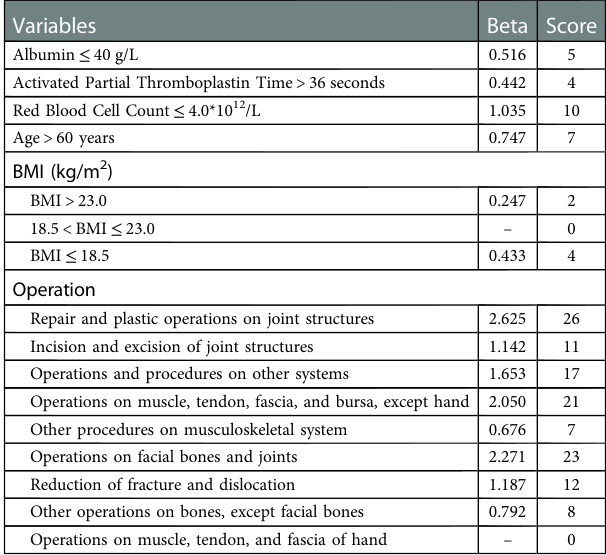
TABLE 3 The risk score model based on the β -coef fi cient of logistic regression